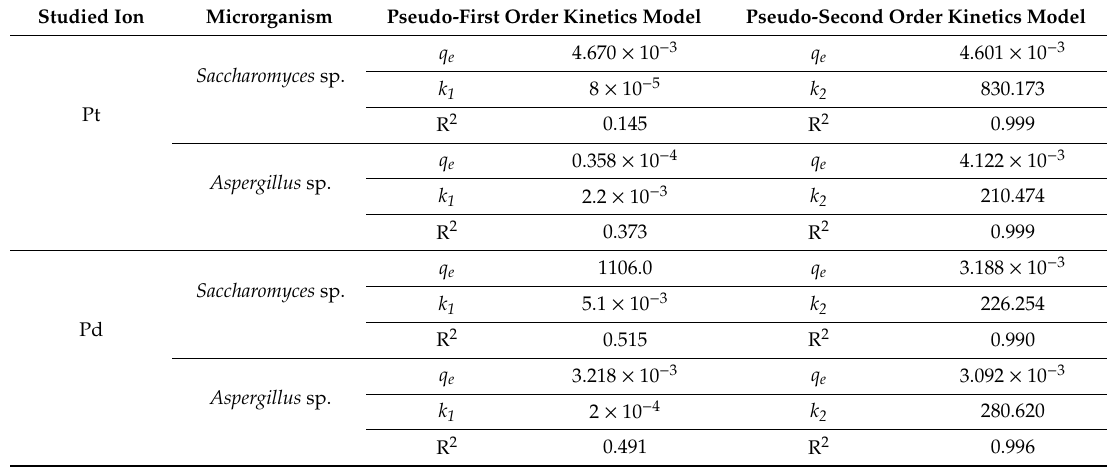
Table 2. The kinetic parameters of Pt and Pd adsorption by examined biosorbents ( q e —the amount of adsorbed ion at equilibrium state (mg g − 1 ), k 1 —the first order kinetic rate (min − 1 ); k 2 —second order kinetic rate (g mg − 1 min − 1 ).